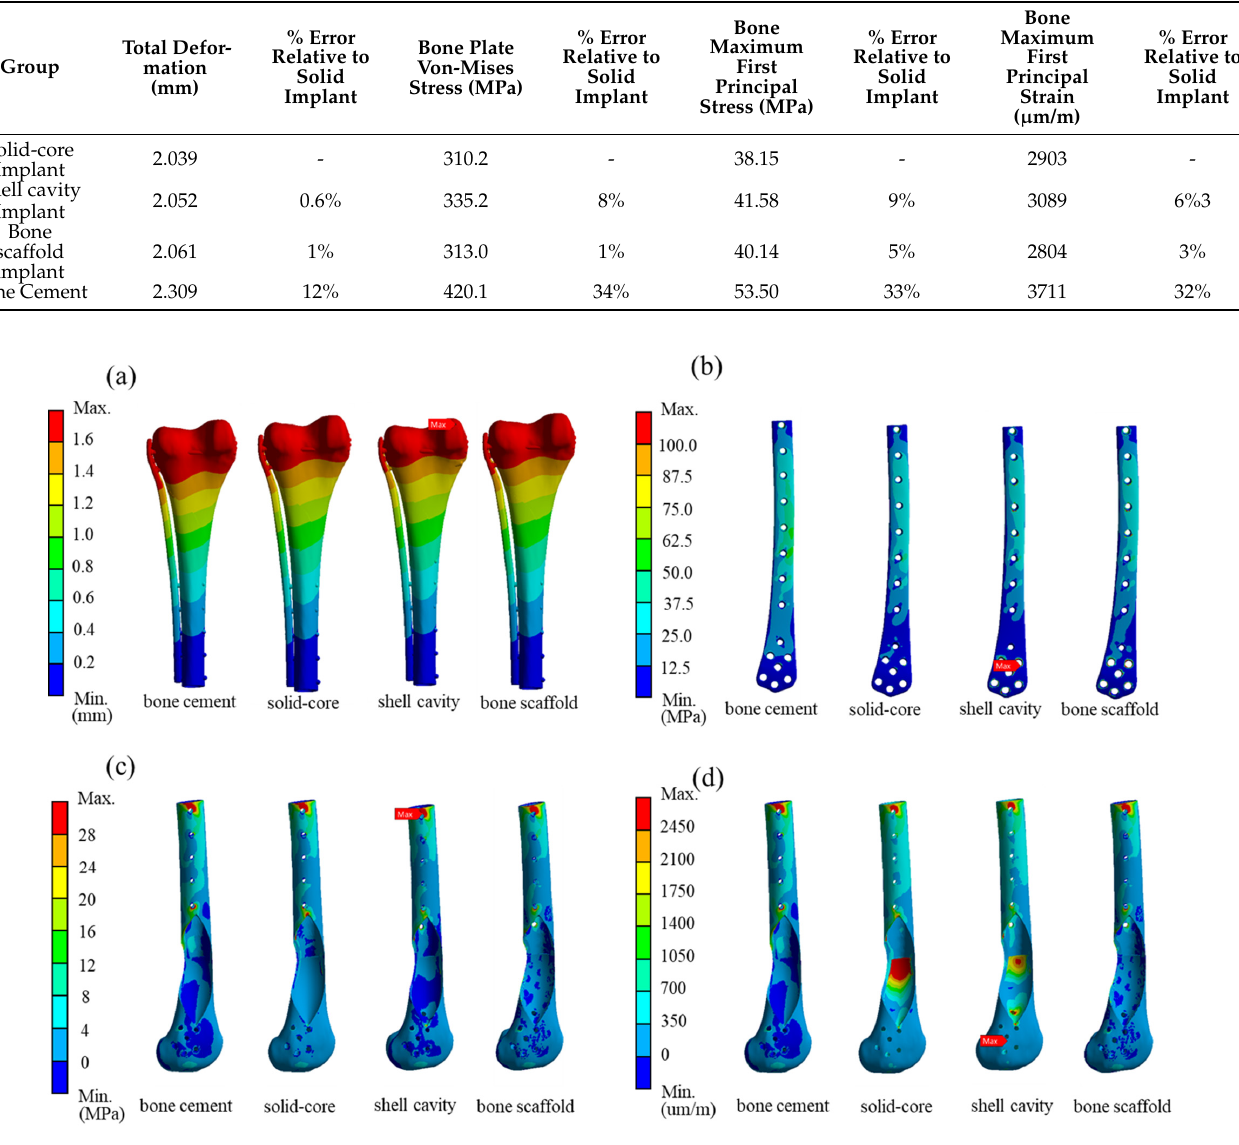
Figure 7. Simulation results for the distal femur defect repaired with solid-core, shell cavity, bone scaffold implants and bone cement. The magnitude and location of the stresses are indicated for ( a ) total displacement; ( b ) bone plate von Mises stress; ( c ) first principal stress on bone; and ( d ) first principal strain on bone.